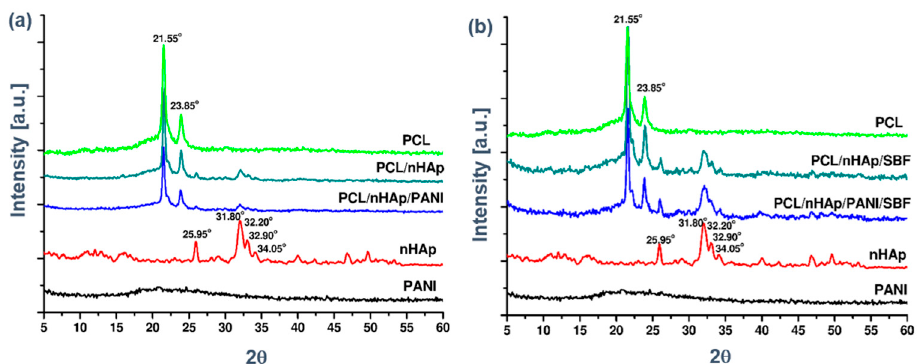
Figure 6. X-ray diffraction patterns for the PCL, PCL/n-HAp and PCL/n-HAp/PANI samples ( a ) before and ( b ) after 14 days of immersion in SBF.